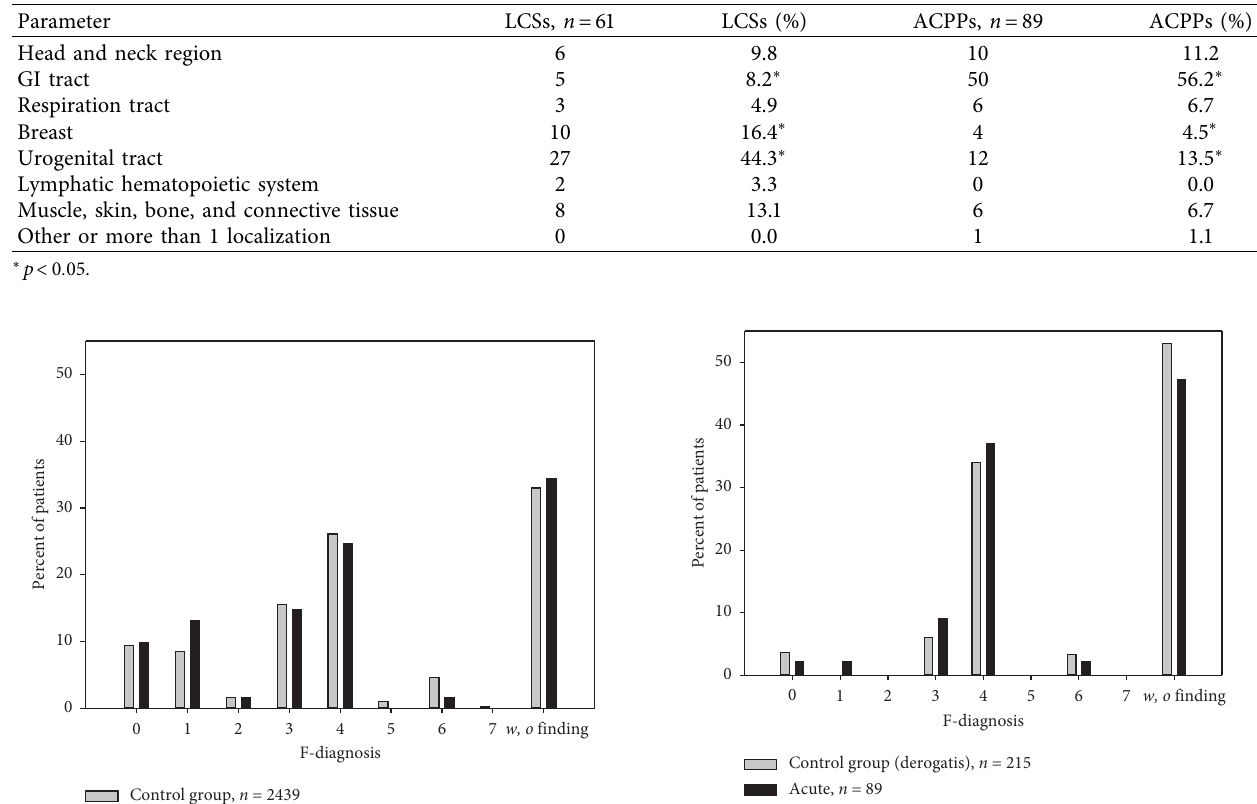
Table 2: Cancer localization in patients with cancer history ≥ 5y (LCSs) and acute cancer pain patients (ACPPs).